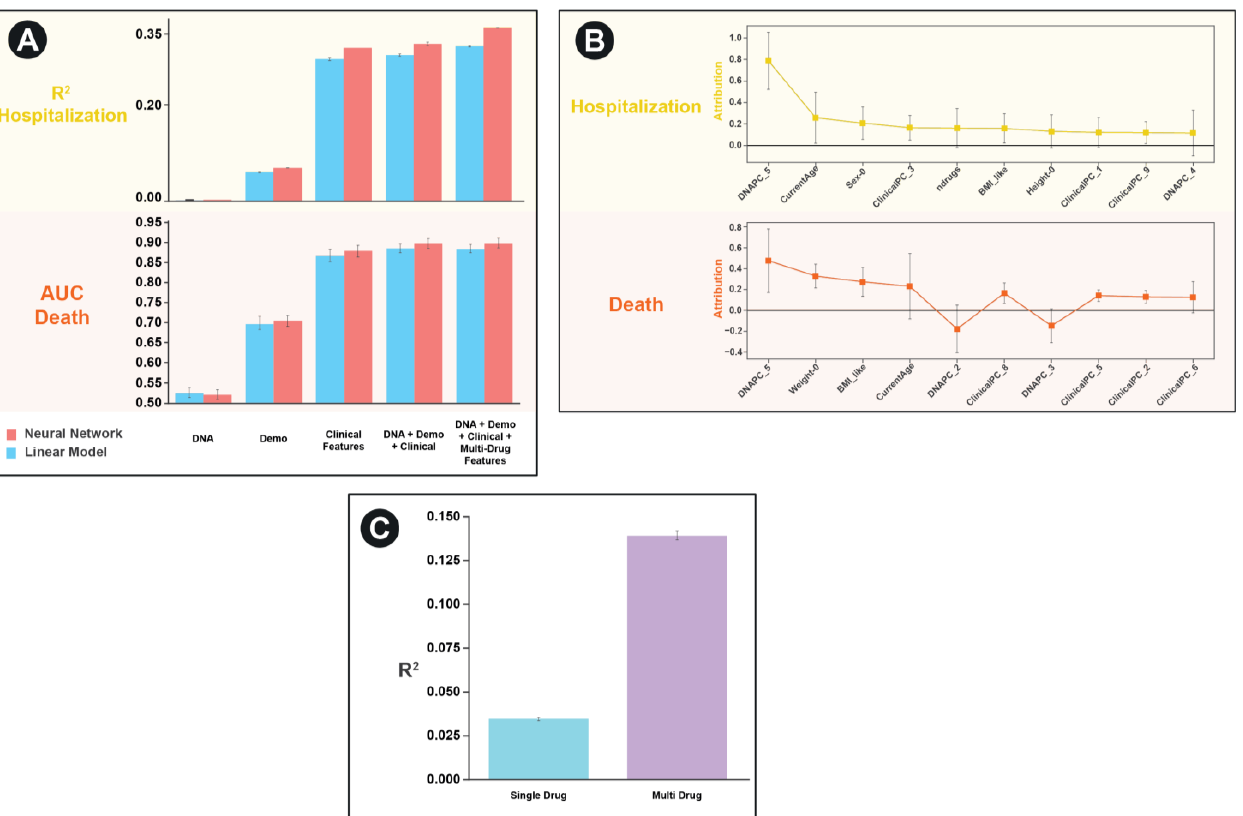
Figure 3. Predictive utility of various features and model architectures for predicting adverse events in the UKBB dataset: ( A ) Results for hospitalization (top) and death (bottom). Red bar corresponds to neural network architecture, blue bar corresponds to linear model. Y -axis is an R 2 measure of model performance on predicting log10 (hospitalization + 1) (top) and AUC for predicting death (bottom). X -axis contains various combinations of features used in the model. Error bars correspond to 95% confidence interval derived from bootstrapping on 5-fold cross-validation (each fold contains 58,312 patients). ( B ) Feature weights (attributions) for each the top 10 most important non-drug structure features in the integrated model for predicting hospitalization in the UKBB dataset (top) and death (bottom). Error bars correspond to ± 1 s.d. ( C ) Bar plot comparing results of using single drug features to using multi-drug features alone for predicting hospitalization. Error bars correspond to 95% confidence interval derived from bootstrapping on 5-fold cross-validation (each fold contains 42,114